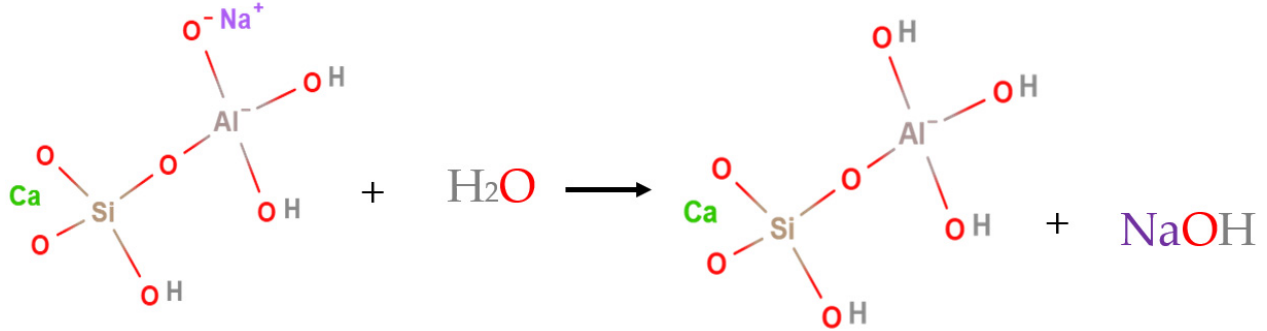
Figure 3. Interaction of activated species within dry activator powder with water.